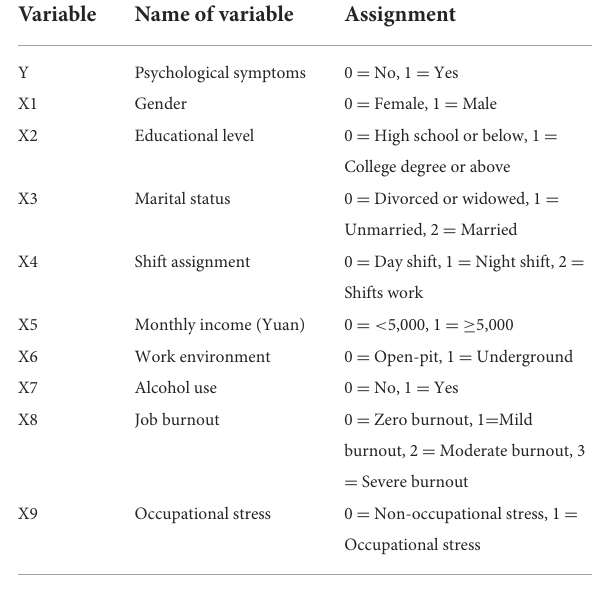
TABLE 5 Variable assignment: Logistic regression analysis.